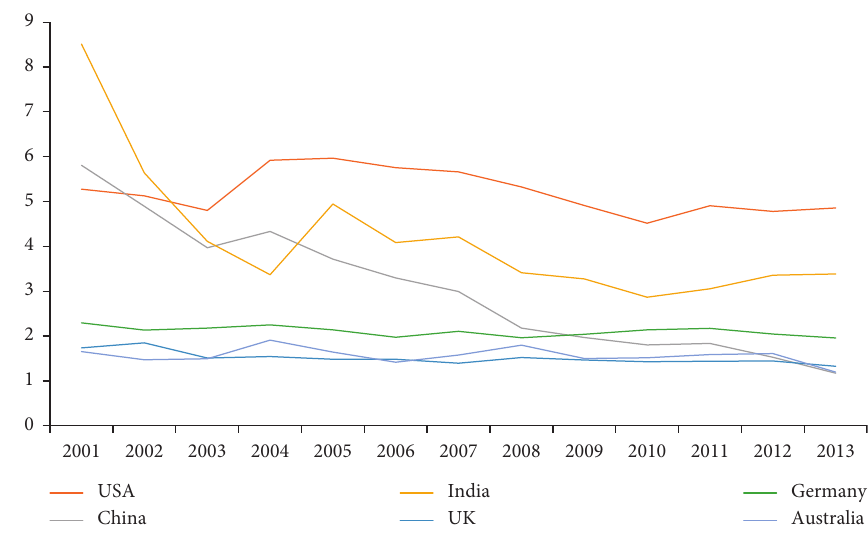
Figure 10: Time evolution of f